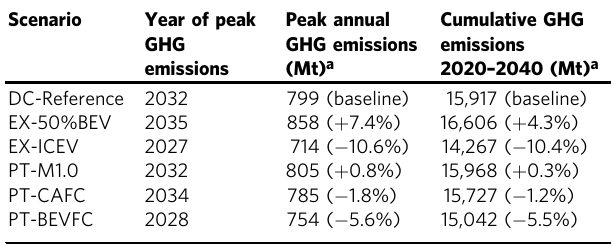
a The percentage in parenthesis represents the difference between that scenario and the DC-reference